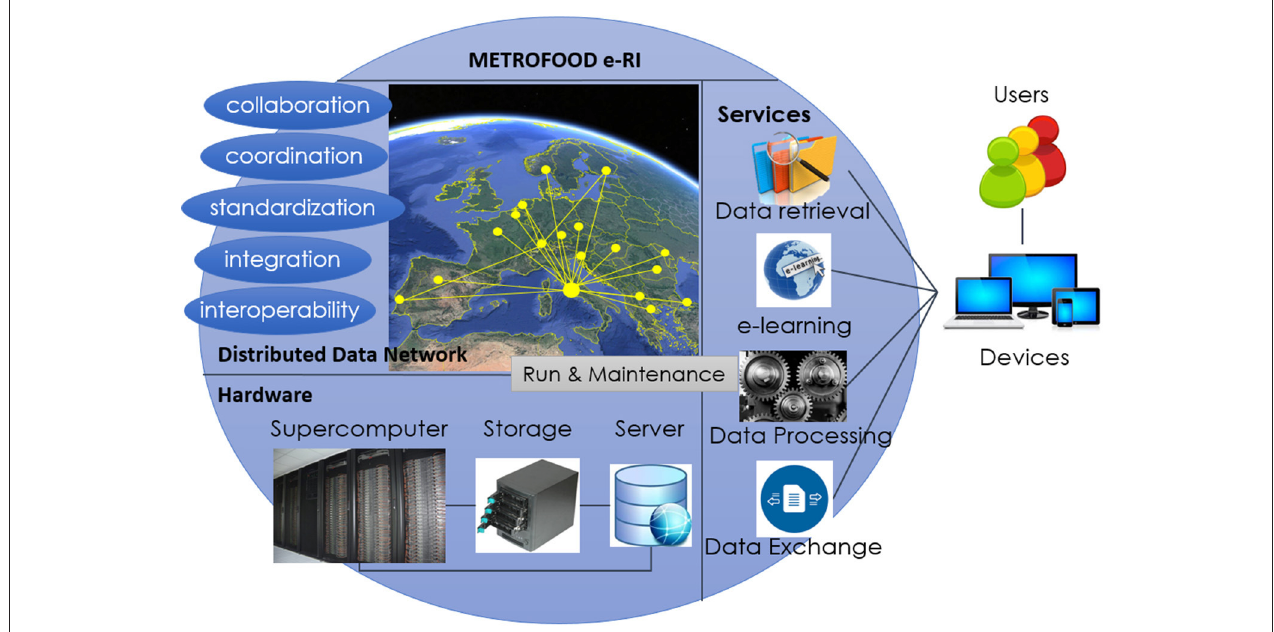
FIGURE 1 | Basic building blocks of the METROFOOD e-RI with data network, hardware, and service layer.